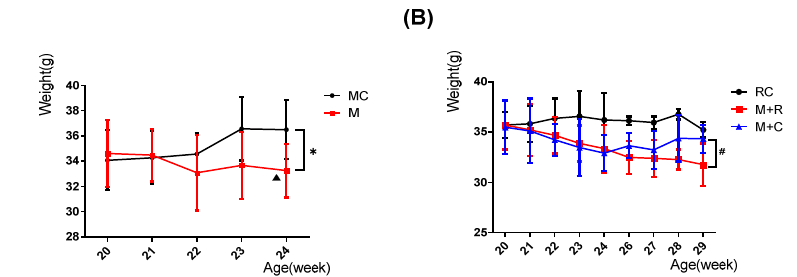
Figure 1. Changes in the weights of mice at different ages in each group. ( A ) Changes in the weight of mice in the MC and M groups; ( B ) Changes in the weight of mice in the RC, the M + R, and M + C groups. (n = 8, Comparison within M group: △ p < 0.05; comparison between MC and M groups: * p < 0.05; comparison between M + R and M + C groups: # p < 0.05.).